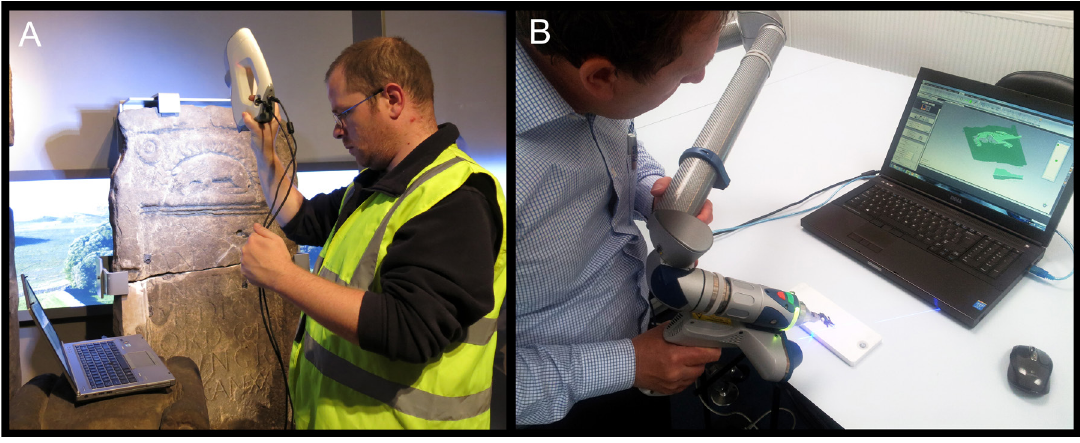
Figure 5. A. Scanning of medium-large Roman stone monuments using an Artec EVA scanner connected to a laptop. B. Scan- ning of Roman artefacts using a Faro Arm scanner connected to a laptop (Image: R.